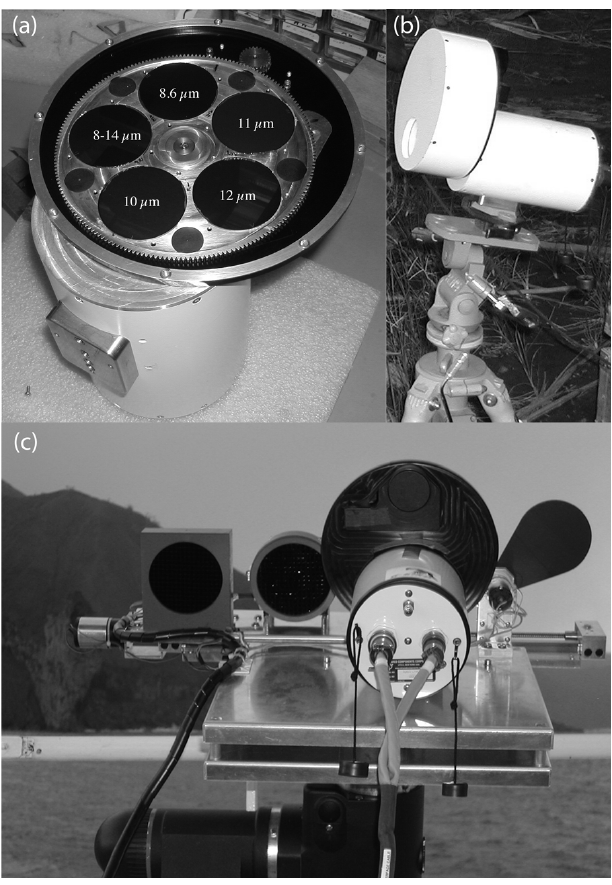
Figure 2. (a) Filters mounted on filter wheel in the arrangement when used for measuring SO 2 gas emissions (central wavelengths in microns are given). (b) “Cyclops” camera mounted on a tripod for field operation. (c) Ship-mounted camera undergoing calibra- tion tests with two moveable blackbodies and an external blackened